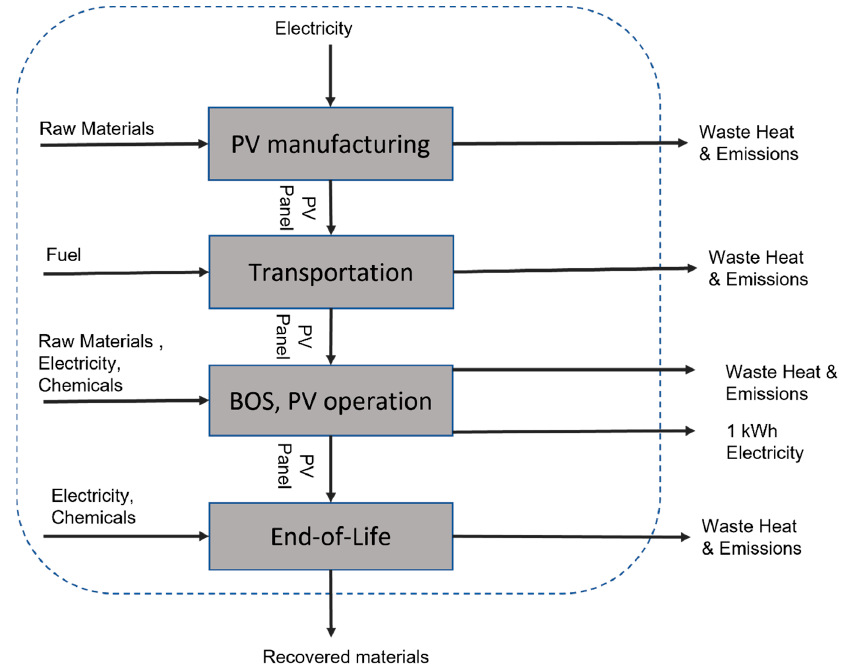
Figure 2. Simplified system diagram showing analysis boundaries, which includes all steps from the extraction of raw materials to manufacturing the panels through transportation, the balance of system components installation and operation of the PV system (collectively referred to as BOS), and end of life of